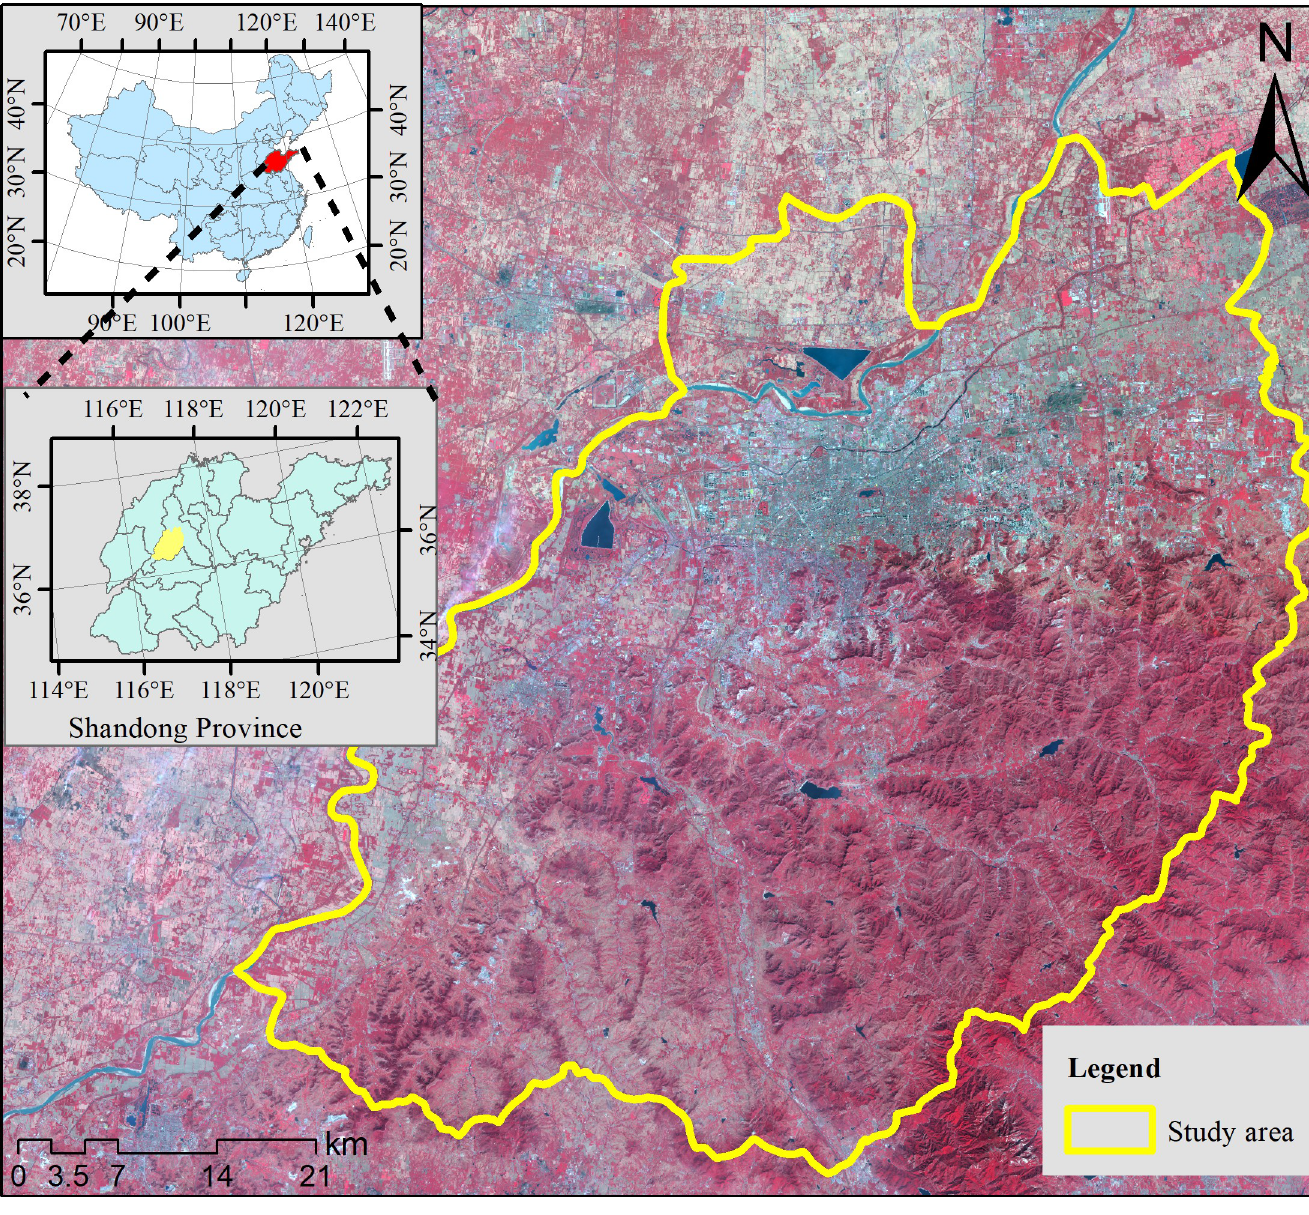
Fig 1. Location of the study area, mainly included urban area and suburb